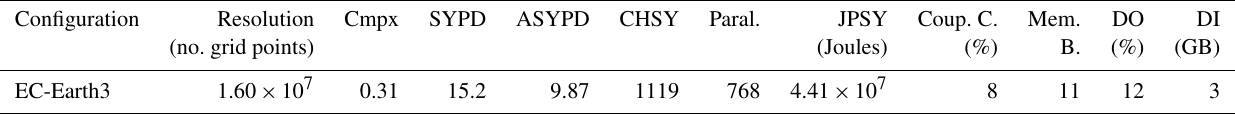
Table 12. CPMIP metrics analysis for EC-Earth3 on Marenostrum4. Complete CPMIP metrics are shown in this table: resolution complexity (Cmpx), SYPD (simulated years per day), ASYPD (actual simulated years per day), CHSY (core hours per simulated year), parallelization, JPSY (Joules per year simulated), Coup. C. (coupling cost), Mem. B.(memory bloat), DO (data output cost), and DI (data intensity). From left to right we have resolution (Resol) as the total number of grid points for all the components used (ocean, atmosphere, and so on). Cmpx includes all prognostic variables of a model. JPSY quantifies the energy cost of the execution. Coup. C. represents the cost associated with the coupling among components (including interpolation and communication calculations; 8% in this case with respect to the total execution time). Mem. B. is the division between the theoretical memory and the real one. DO is the cost of the output process (12% in this case with respect to the total execution time). DI is the output volume in GB per day of simulation.